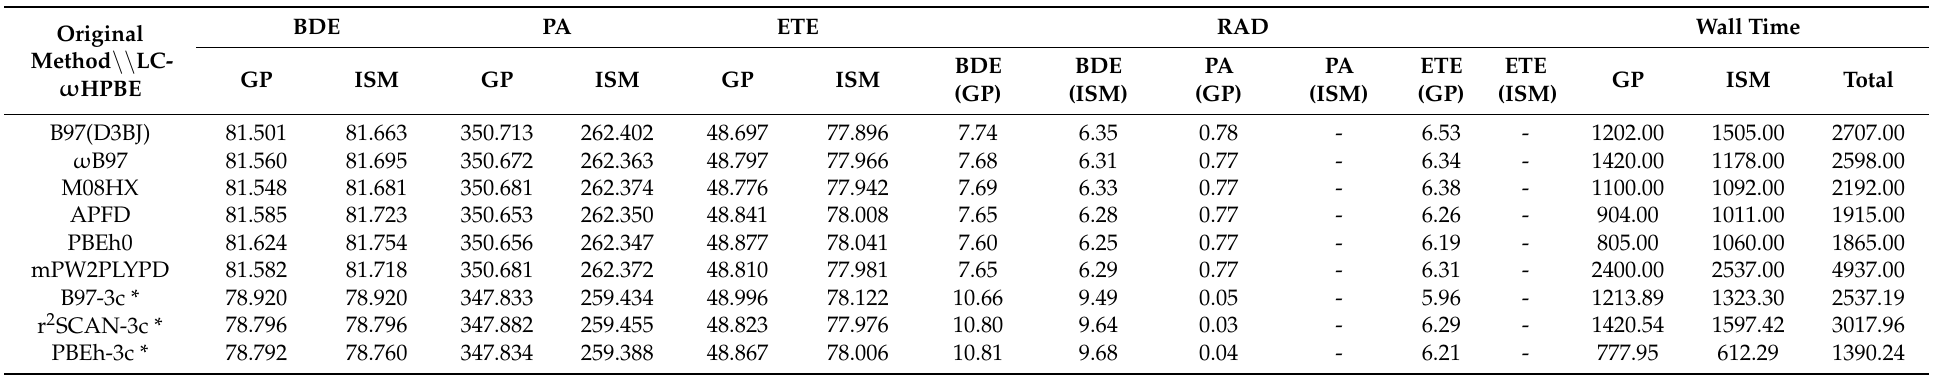
Table 3. The BDEs, PAs, and ETEs (kcal/mol), their respective estimated RADs (%), and the total wall times (s) performed using the original method/pcseg-1 \\ LC - ω HPBE/pcseg-1 .